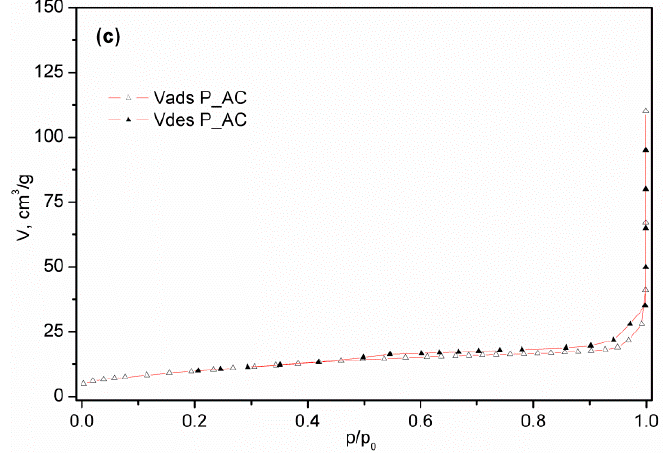
Figure 4. N 2 adsorption–desorption isotherm of activated samples: ( a ) C_AC, ( b ) A_AC, and ( c ) P_AC.